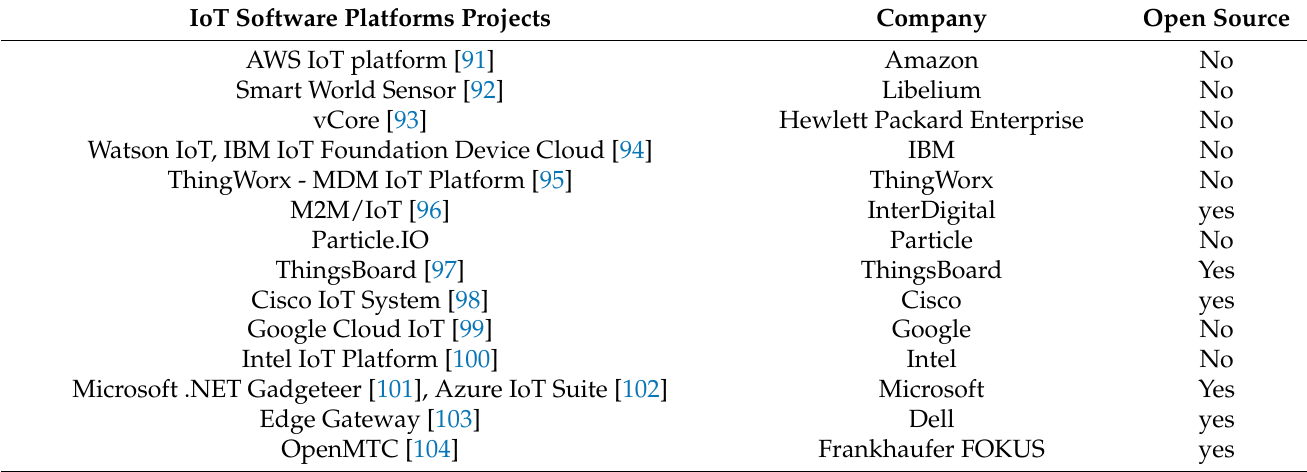
Table 3. Summary of IoT software platforms